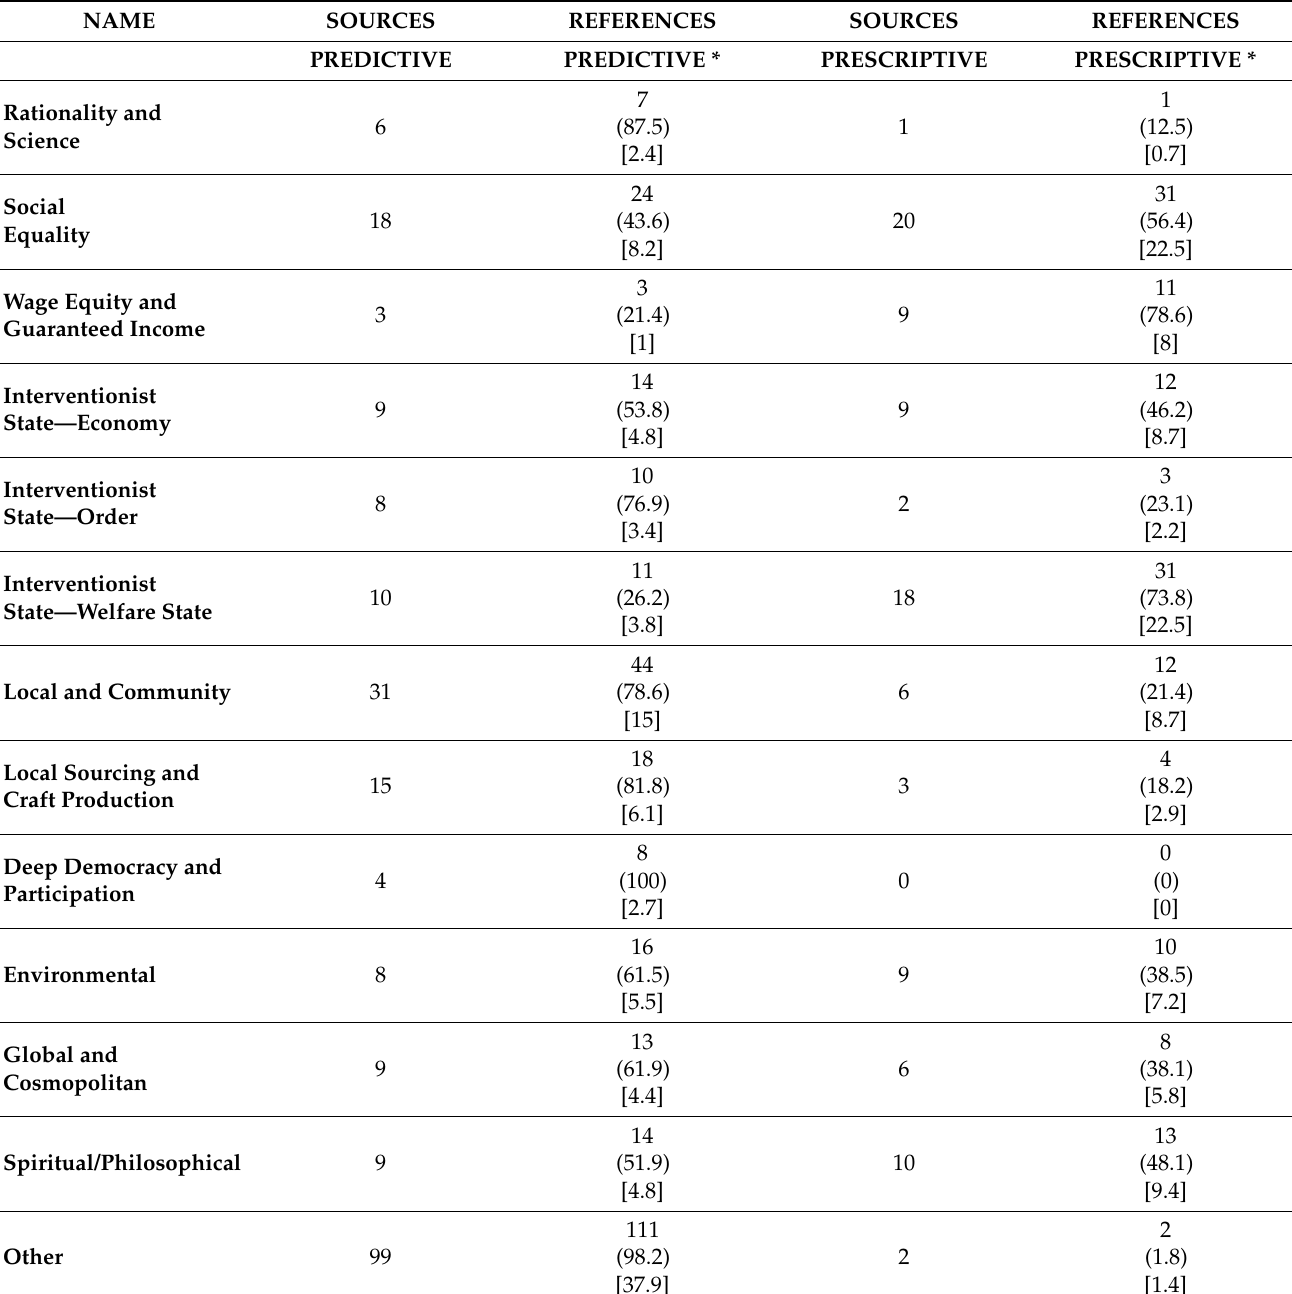
Table 2. Nodes and Number of References Derived from Sources